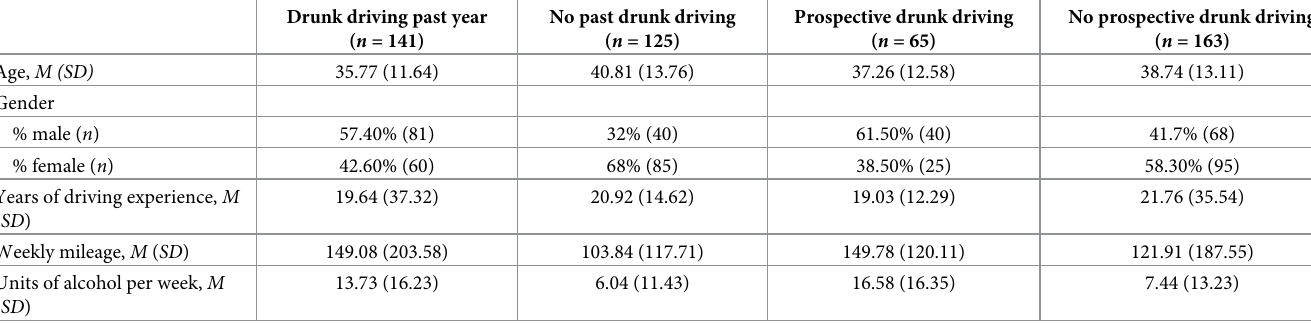
Table 2. Sample characteristics Study 2 per